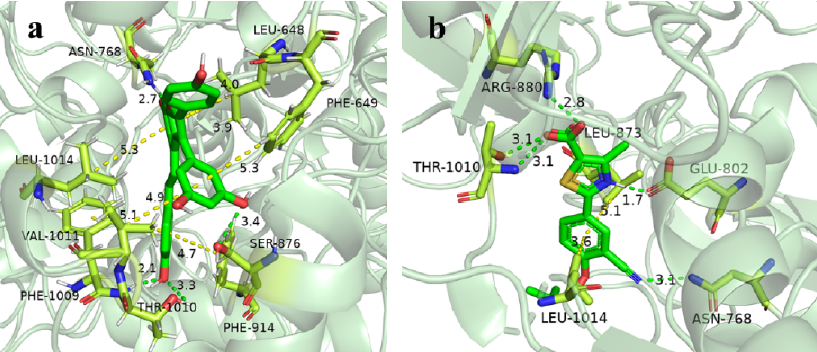
Figure 10. Docking results of viniferifuran (pink-purple)–XO and febuxostat (green)–XO and su- perimposed docking conformations of viniferifuran and febuxostat in the active pocket of XO.